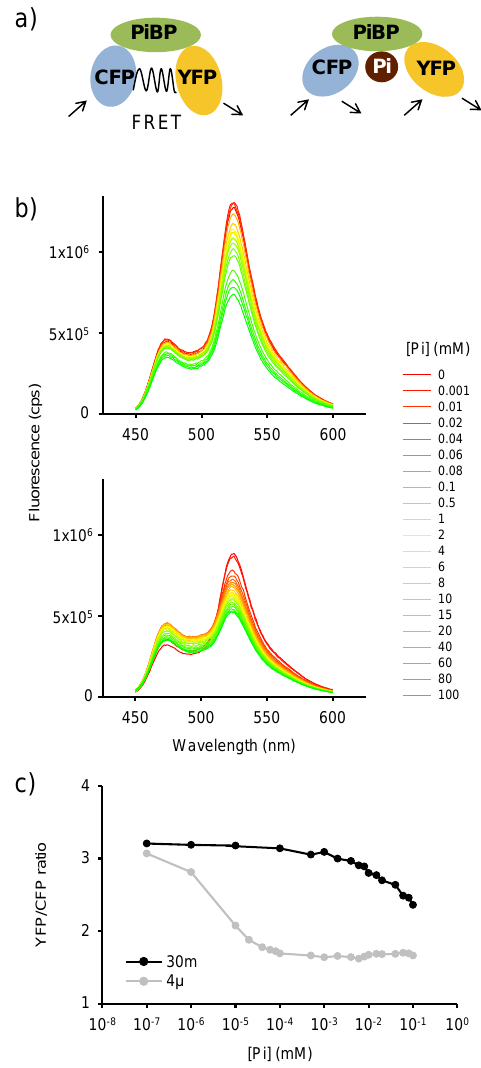
Figure 1. Pi-dependent changes in FRET ratios of purified FLIPPi Pi sensors. ( a ) Simplified scheme of FLIPPi FRET-based sensors [20] depicting the Pi binding bacterial periplasmic Binding Protein (PiBP) fused to Cyan Fluorescent Protein (CFP) and Yellow Fluorescent Protein (YFP) as FRET partners. ( b ) In vitro emission spectra of the low-a ffi nity FLIPPi-30m and high a ffi nity FLIPPi-4 µ protein sensors in response to a series of Pi bu ff er solutions with Pi concentrations between 1.0 × 10 − 3 and 1.0 × 10 2 mM; CFP and YFP emission peaks correspond to a wavelength of approximately 470 and 520 nm, respectively. Fluorescence intensity was measured in counts per second (cps). Measurements were performed with at least 3 sets of independently purified protein. ( c ) In vitro ligand-dependent FRET (YFP / CFP) ratio change in response to Pi bu ff er solutions, calculated from (b), for FLIPPi-30m (30m) and FLIPPi-4 µ (4 µ ) sensor